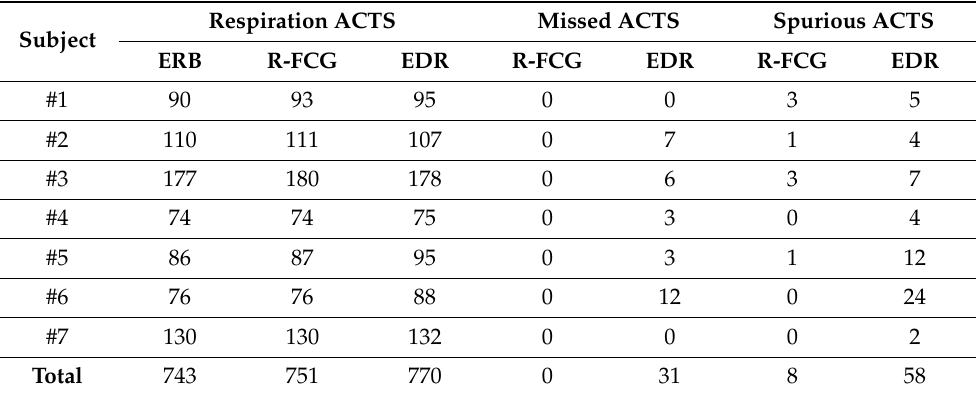
Table 1. Respiration acts detected in the ERB, R-FCG and EDR signals. The missed and spurious acts are reported for the R-FCG and EDR signals with reference to the acts detected in the ERB